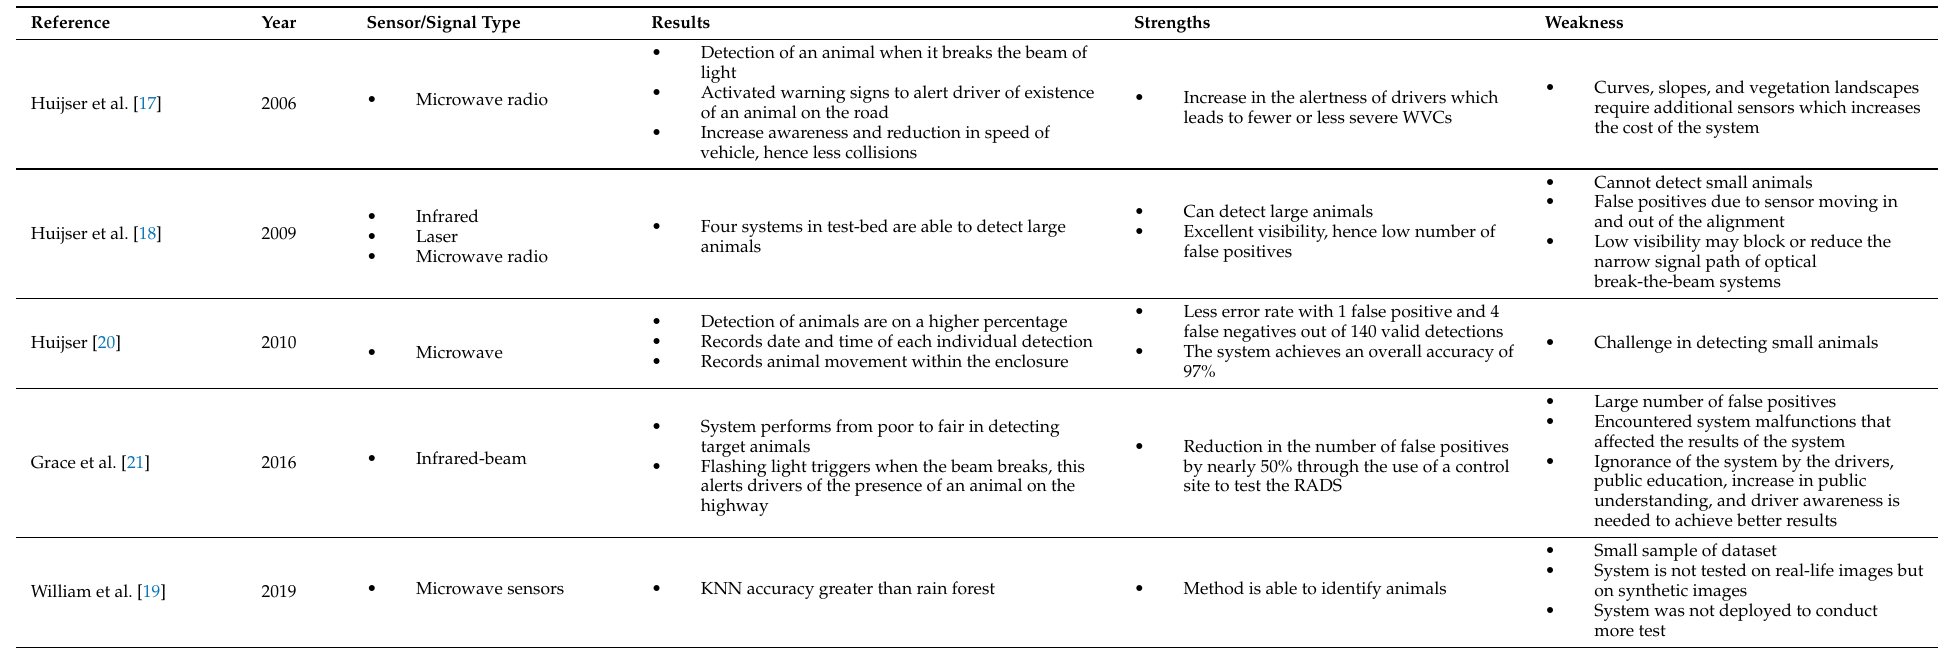
Table 6. A comparison of break-the-beam systems in terms of their sensor types, performances, strengths, and